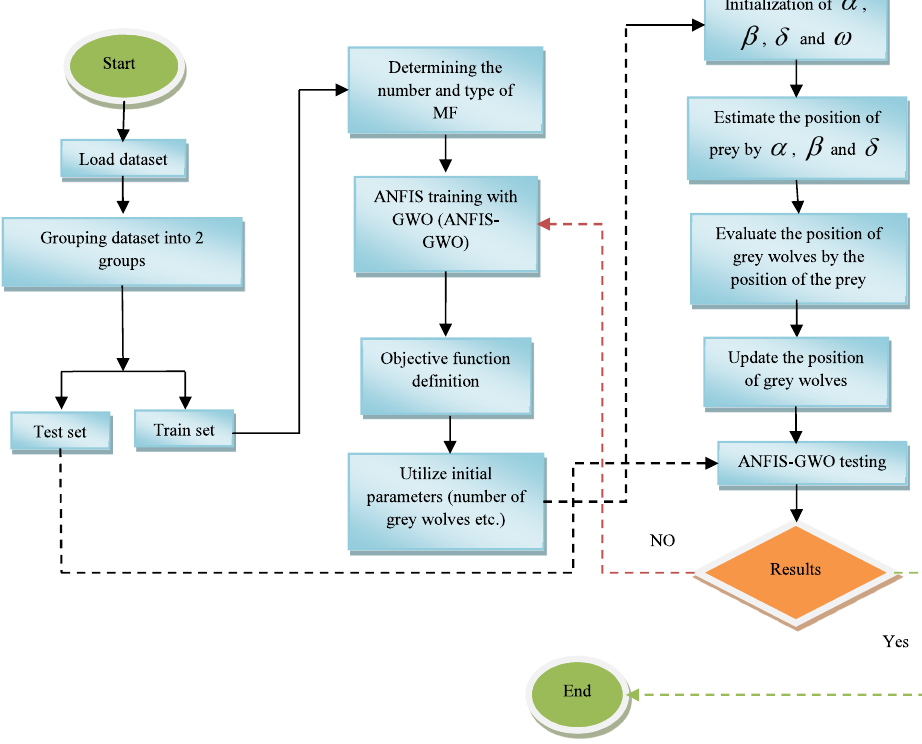
Figure 5. The flowchart of ANFIS-GWO